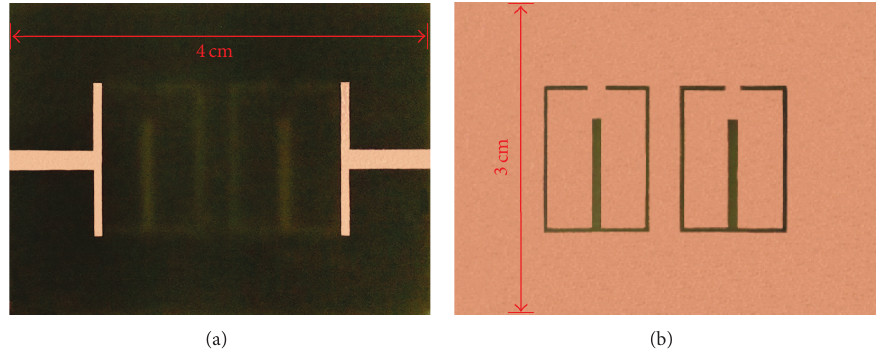
Figure 6: Photographs of the fabricated DSLR dual-band filter. (a) Top view. (b) Bottom view.